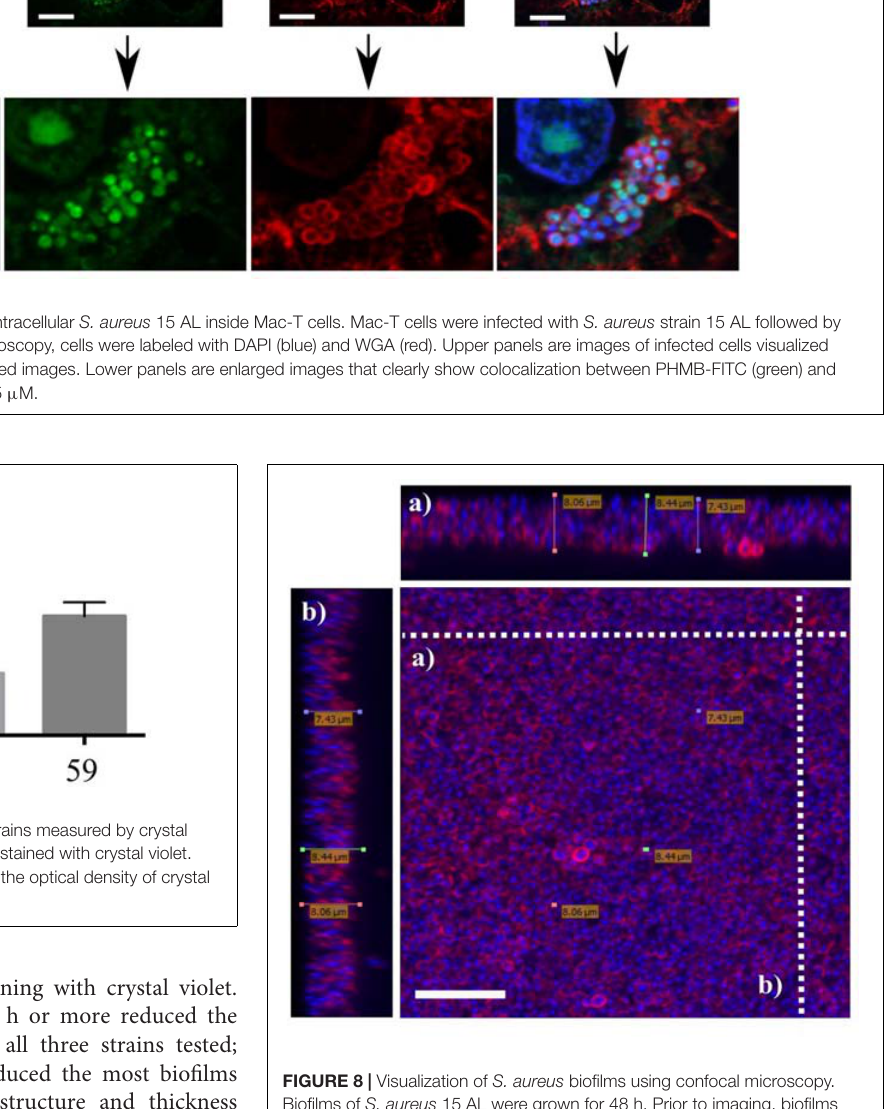
FIGURE 8 | Visualization of S. aureus biofilms using confocal microscopy. Biofilms of S. aureus 15 AL were grown for 48 h. Prior to imaging, biofilms were stained with DAPI (blue) for S. aureus nuclei staining and WGA (red) for N -acetylglucose amine staining. Confocal microscopy z -stack projection moved through 111 slices across the cell. (a) Horizontal cross-section of biofilms (b) Vertical cross-section of biofilms. White scale bar is 7.5 µ